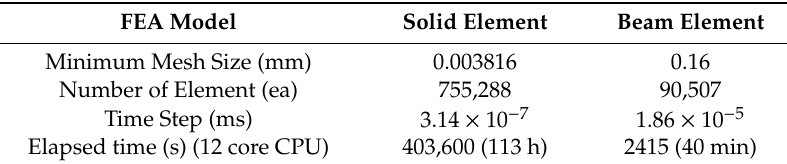
Figure 15. Solder joints modeling. ( a ) Solid model (3D element); ( b ) beam model (1D element). Table 5. Comparison of the solid element and the beam element in FEA model.